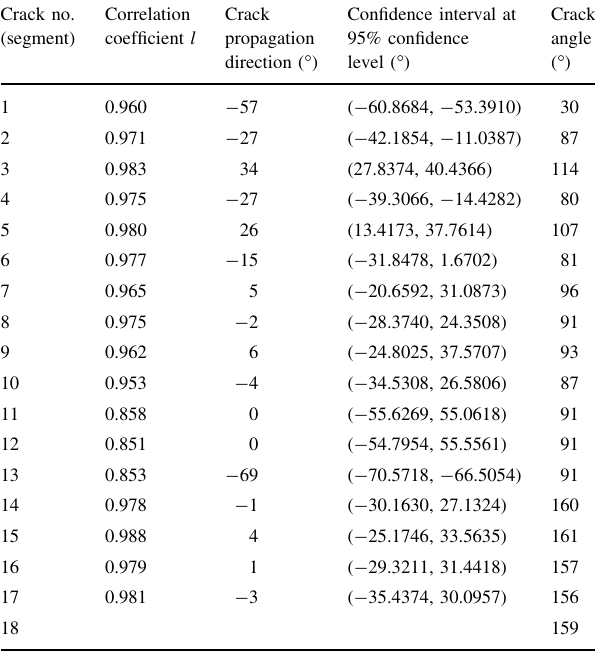
Table 2 Statistical results of rail crack propagation directions for 50 km/h train Crack no. (segment)